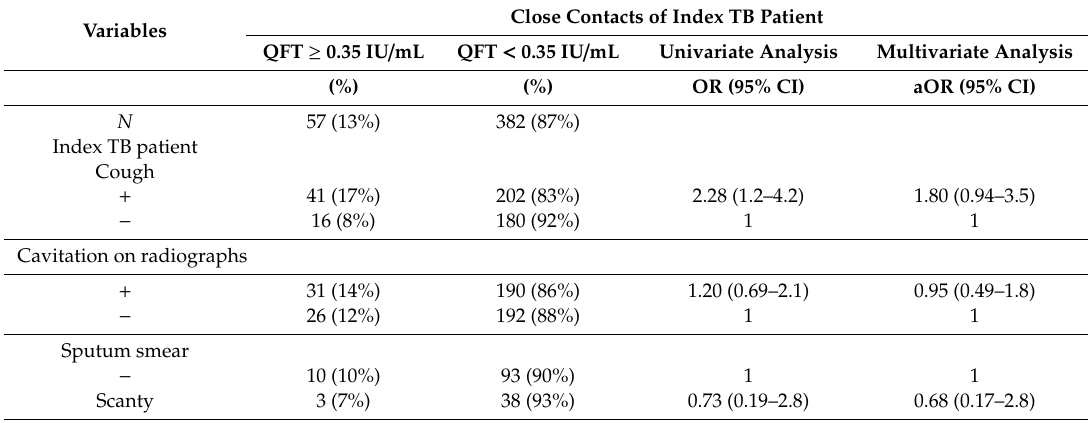
Table 2. QuantiFERON ® -TB Gold In-Tube (QFT) positivity of index tuberculosis (TB) patient close